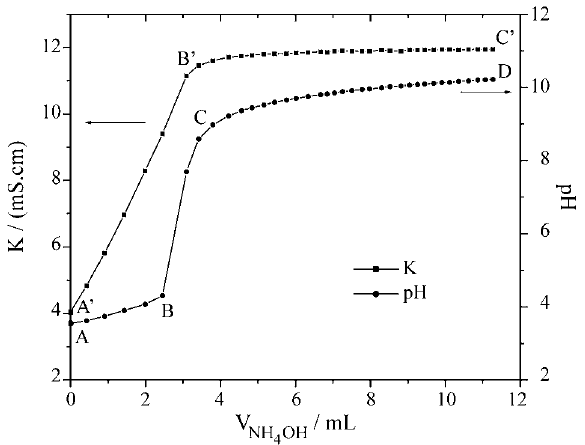
Figure 1b. Primera derivada de la cura potenciométrica para una disolu- ción 0.02 molar de Al 2 (SO 4 ) 3 .